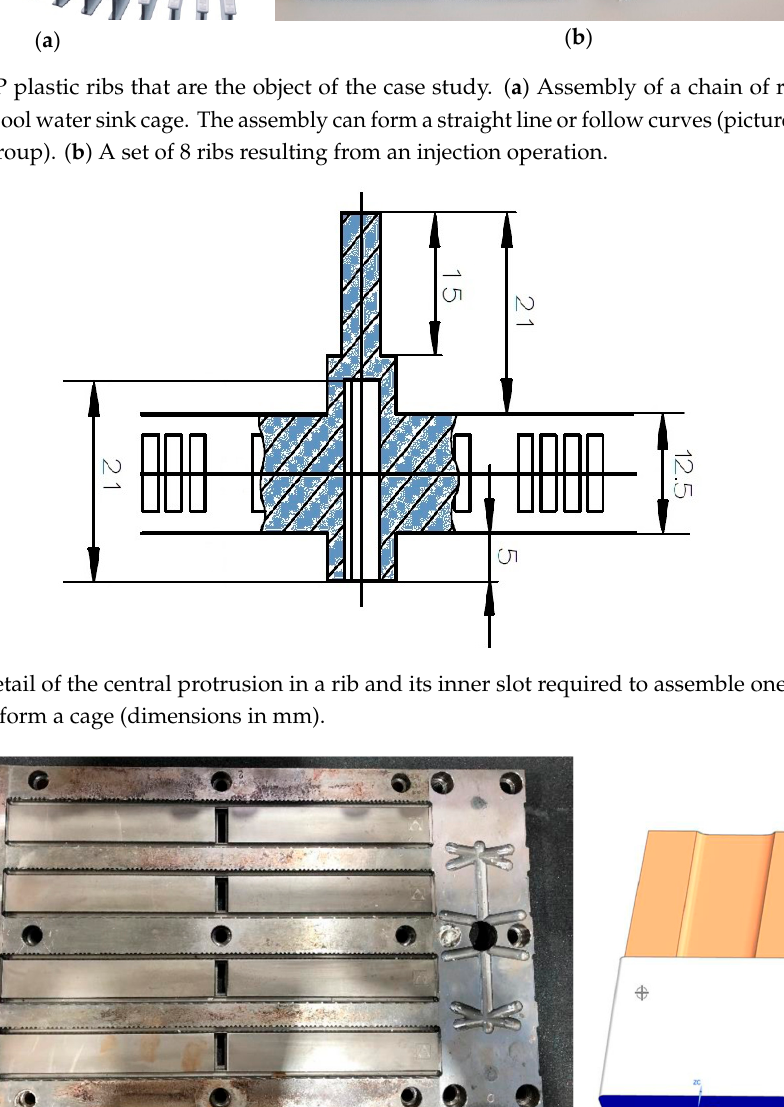
Figure 4. SEM investigation of AM Corrax powder raw material. Image courtesy of voestalpine group. With this combined material and technology -Corrax® and Selective Laser Melting (SLM)-, it is possible to develop a new design for the cooling inserts [21] which could include intricated internal piping cooling geometries (see Figure 5a–e). Furthermore, and concerning the material selection, it must be taken into consideration that in the cooling channels, the coolant will also have the potential